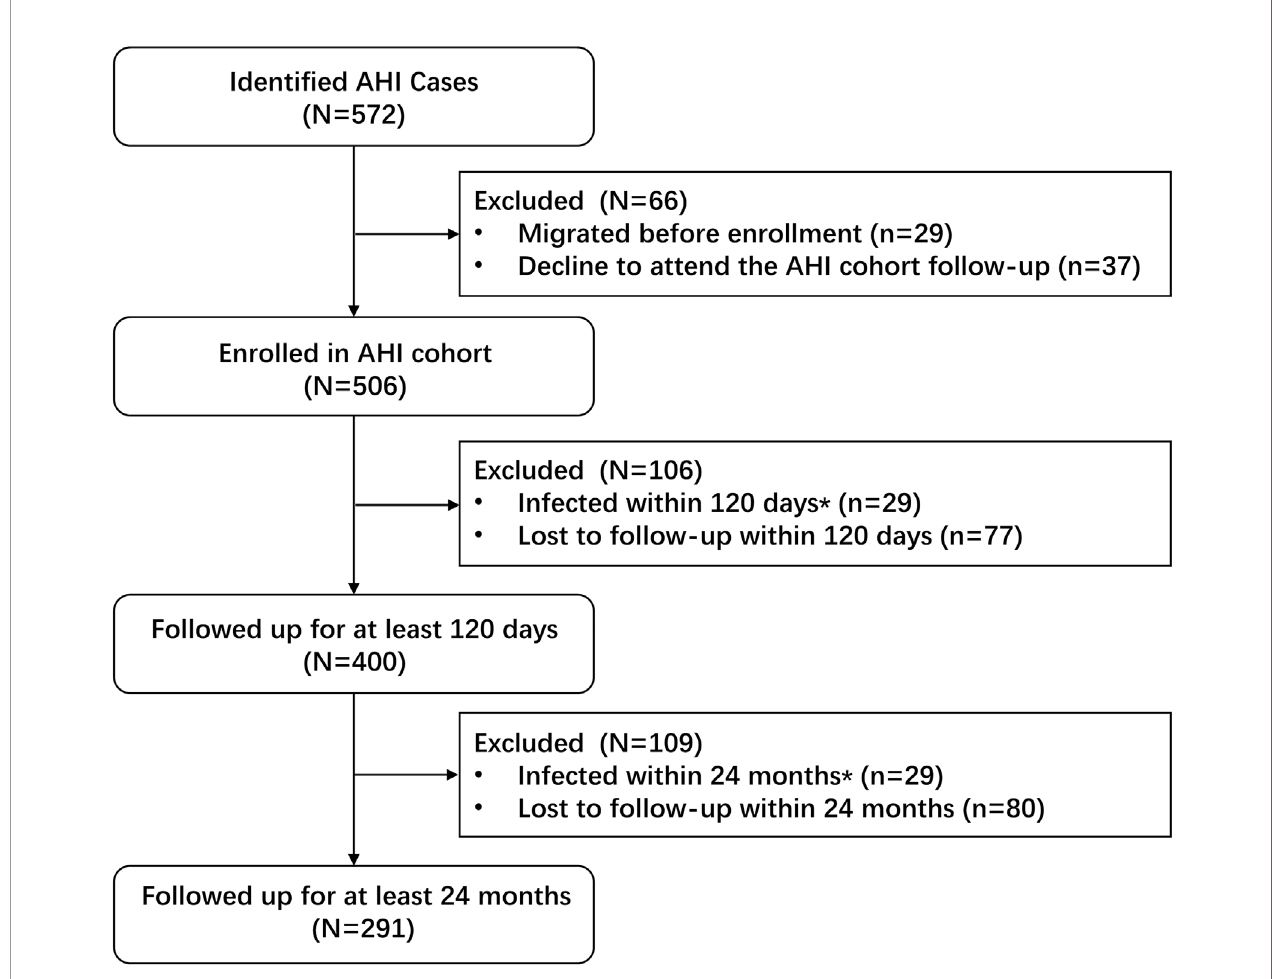
FIGURE 2 | The diagram of AHI cohort subjects